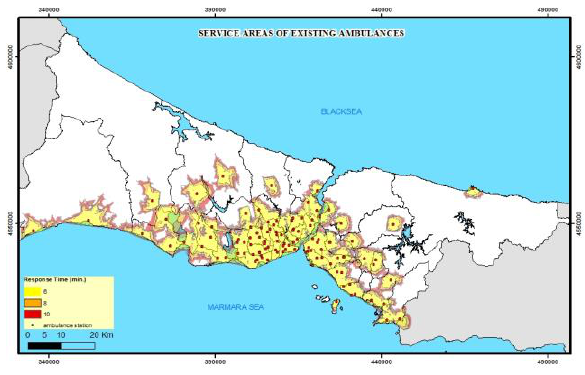
Figure 3. Service areas of existing ambulance stations